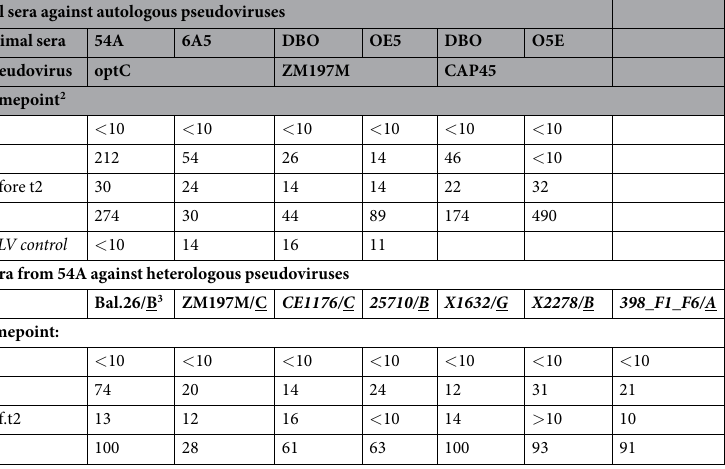
Table 1. Assessment of neutralizing activity (ID 50 ) 1 against HIV-1 in dromedaries’ sera. 1 serum dilution resulting in 50% neutralization; 2 immunization timepoint according to Fig. 2; 3 HIV-1 subtype is underlined, Tier 2 isolates are in